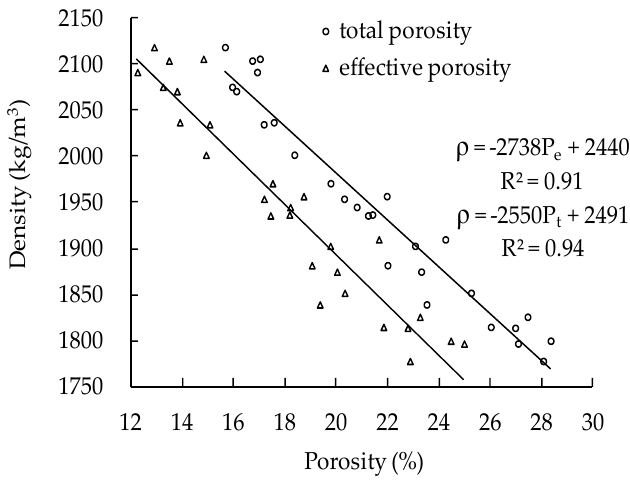
Figure 4. Relationship between density and porosity.